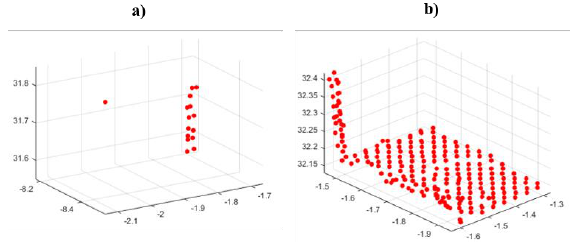
Figure 8: Image of two obstacle candidates of route B: a non- obstacle (a) and obstacle (b).